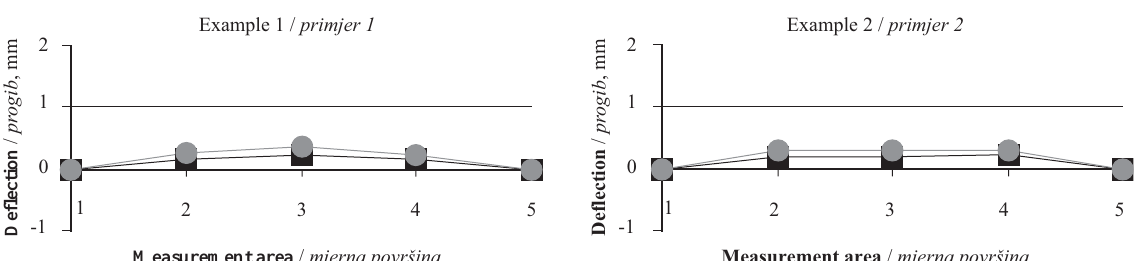
Figure 4 Defl ection of boards asymmetrically veneered on one large side – large difference of shrinkage values Slika 4 . Progib ploča koje su asimetrično furnirane s obje strane - velika razlika između vrijednosti